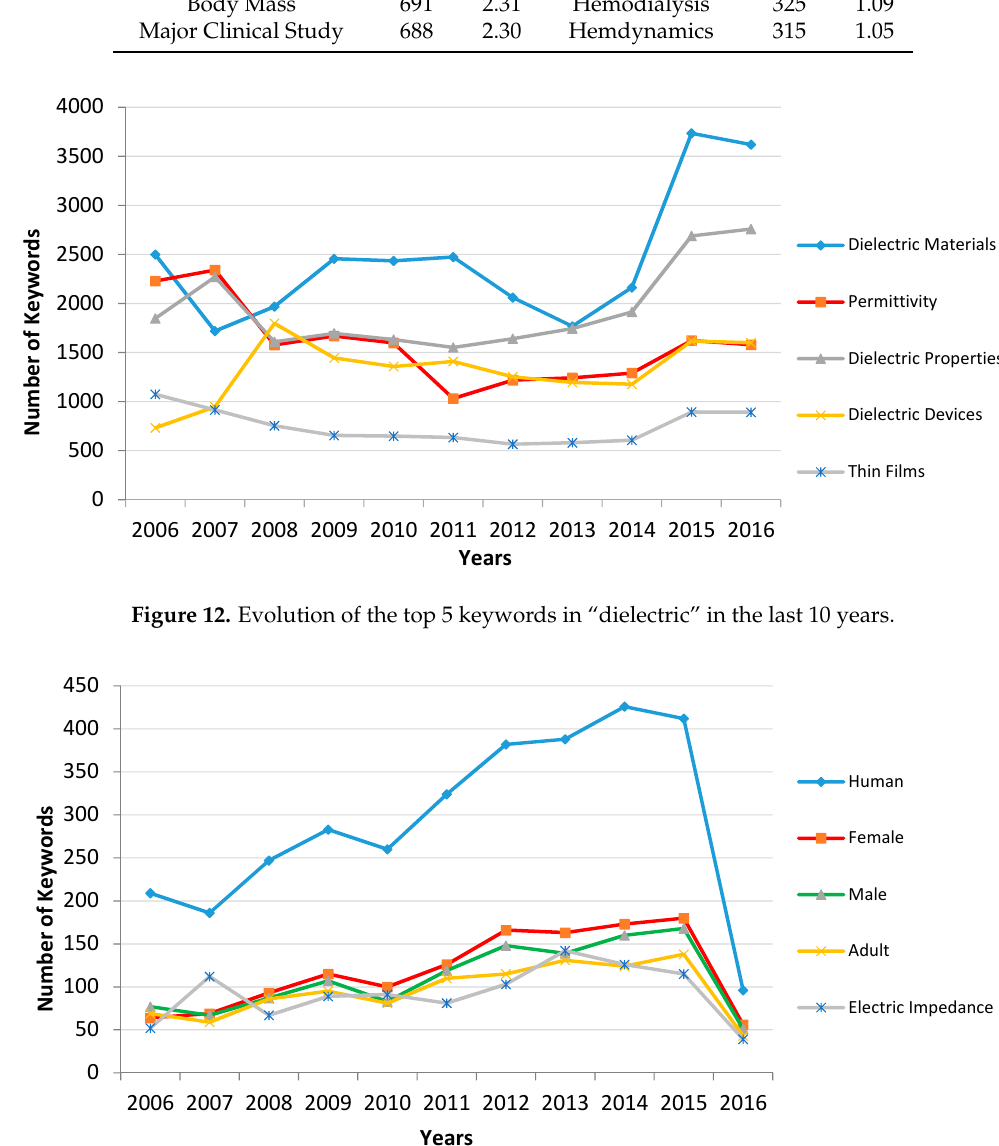
Figure 13. Evolution of the top 5 keywords in bioimpedance in the last 10 years.